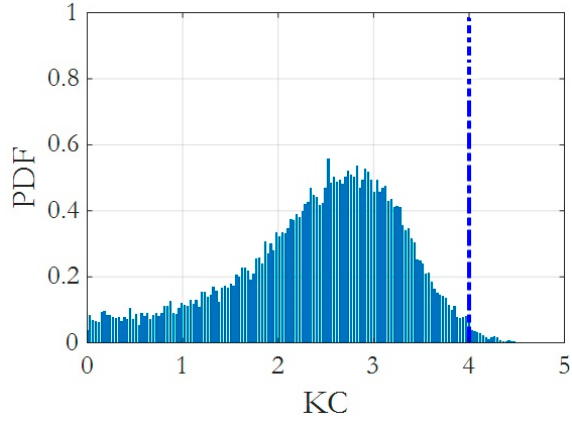
Figure 5. Probability distribution of KC [27].